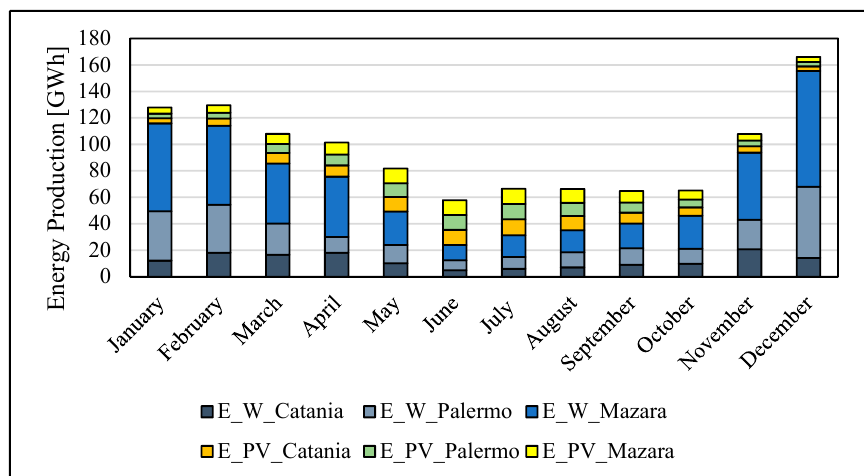
Figure 14. Annual electrical production in scenario 5% (Case B).